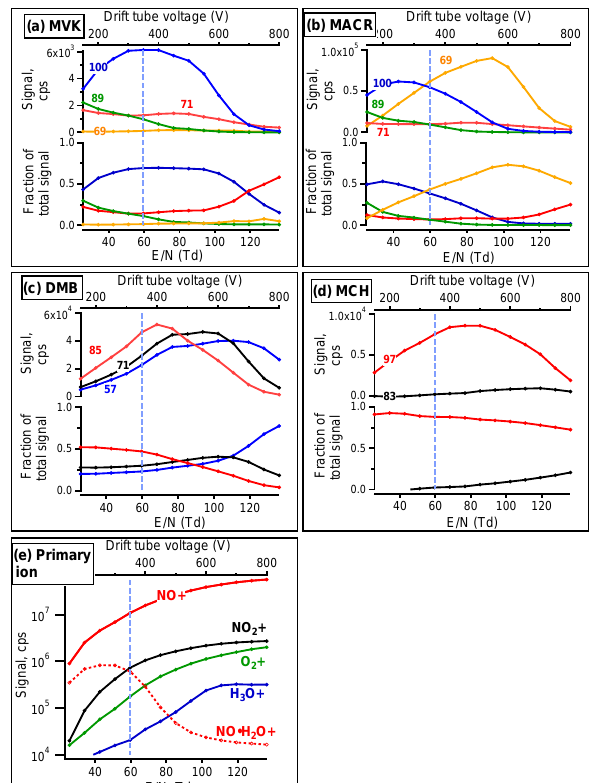
Figure 2. VOC and primary product ion dependence on drift tube voltage. Traces are labeled by the nominal product ion m/z in Th. (a) Methyl vinyl ketone; (b) methacrolein; (c) 2,2-dimethylbutane; (d) methylcyclohexane; (e) primary ions and clusters. The dashed line indicates the selected operating voltage. Experiment conducted in dry air (H 3 O + is from residual water in the instrument and in commercial ultra-zero